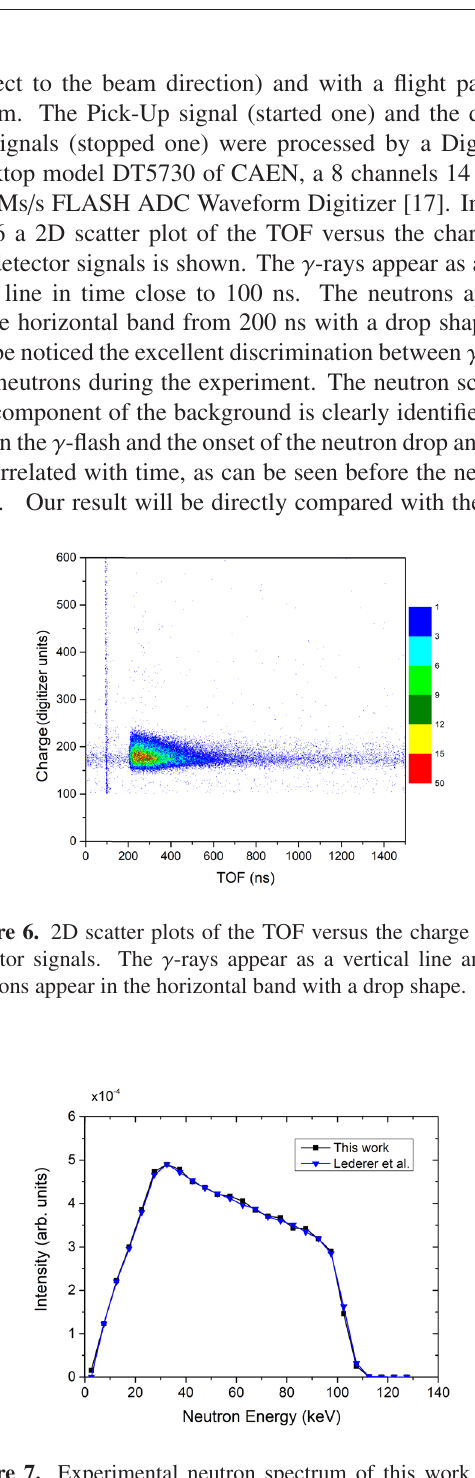
Figure 7. Experimental neutron spectrum of this work at 0 ◦ , 50 cm flight path, and 500 kHz (black line + squares) compared to Lederer et al. [12] (blue line + triangles) in bins of 5 keV. Sta- tistical uncertainties are smaller than the black square